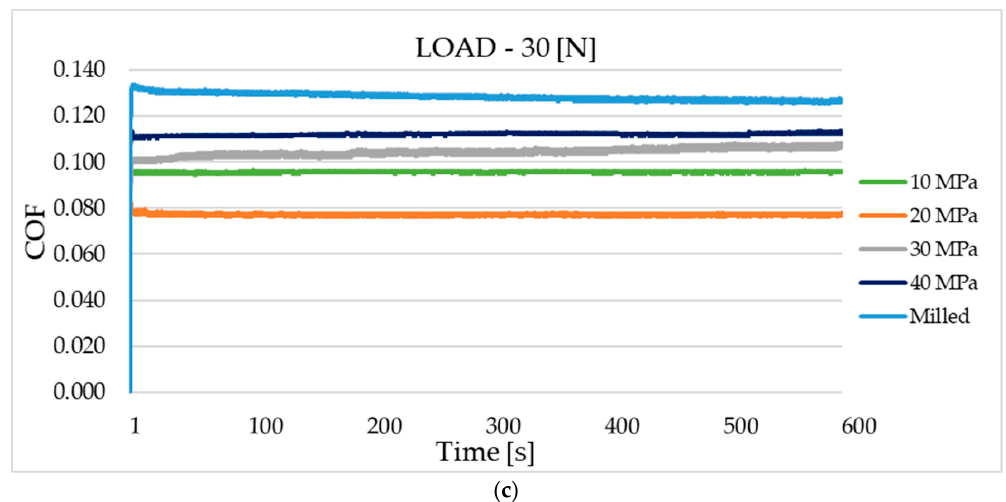
Figure 7. The friction coefficient against time for various sliding pairs under the load of 10 N ( a ), 20 N ( b ) and 30 N ( c ).